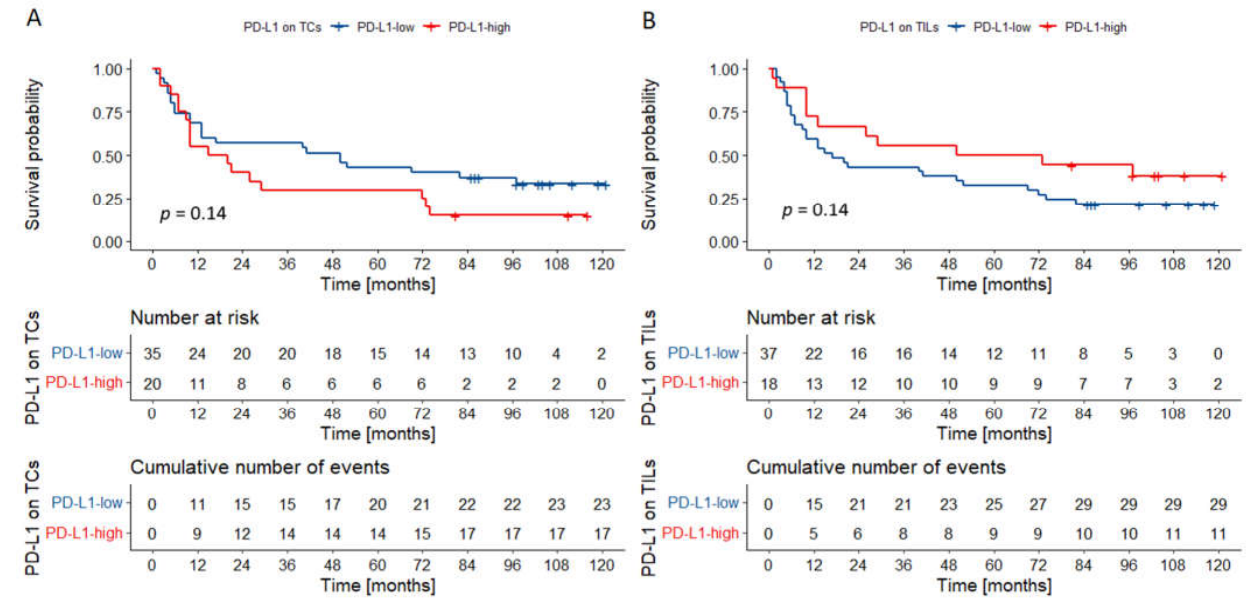
Figure 4. Overall survival probability curve according to PD-L1 expression on TCs ( A ) and TILs ( B ) in OSCCs of the tongue/floor of the oral cavity ( A , B ). There was a trend towards worse overall survival in cancers of the tongue/floor of the oral cavity with high PD-L1 expression on TCs. An opposite trend was observed for PD-L1 expression on TILs. p values were calculated with the log-rank test. Abbreviations: TCs—tumor cells; TILs—tumor infiltrating lymphocytes; OSCC—oral squamous cell carcinoma.